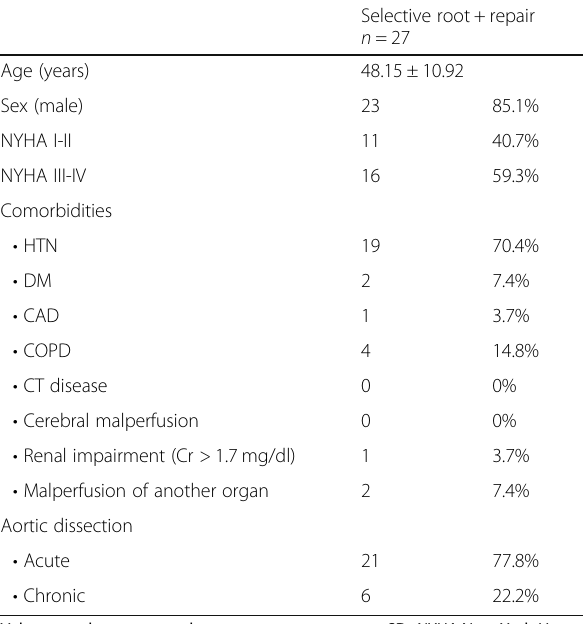
Table 1 Patients ’ demographics and characteristics